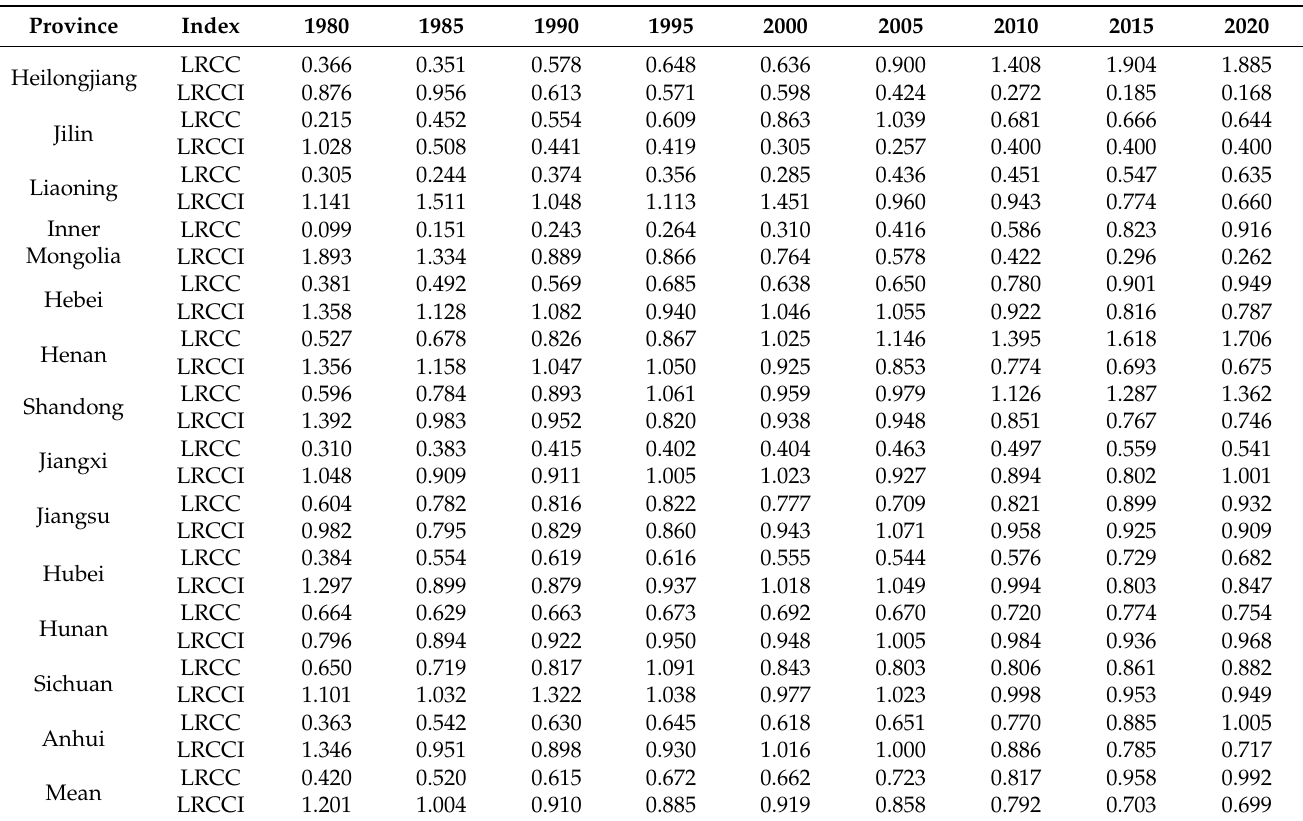
Table 3. LRCC and LRCCI of 13 provinces in China’s major grain-producing areas (unit: 100 million people,